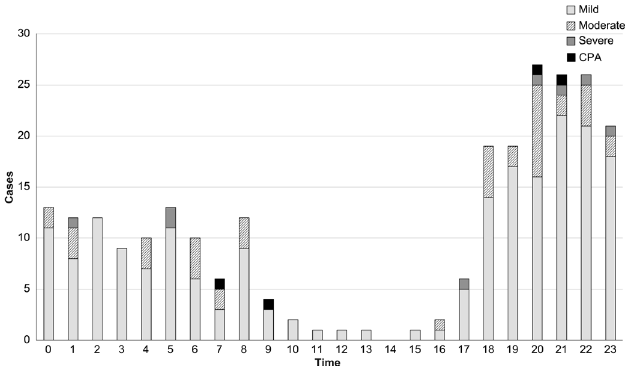
Figure 7. Frequency of Ambulance Dispatch to Hotel/Lodge by Time and